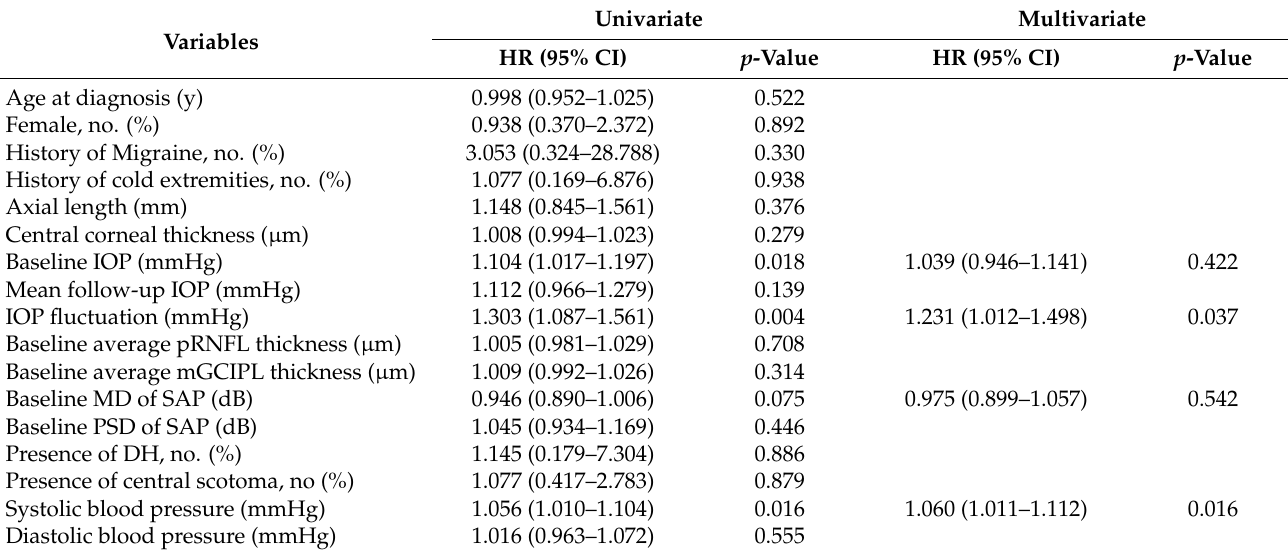
Table 2. Factors associated with TNF- α -positive in the aqueous humor of open-angle glaucoma